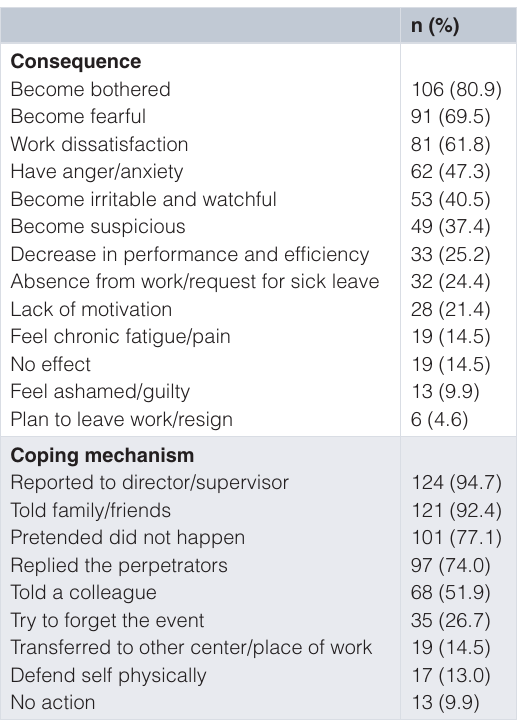
Table 5. Consequences of workplace violence and coping mechanisms reported by reported by security personnel at a university hospital in Egypt in the past year